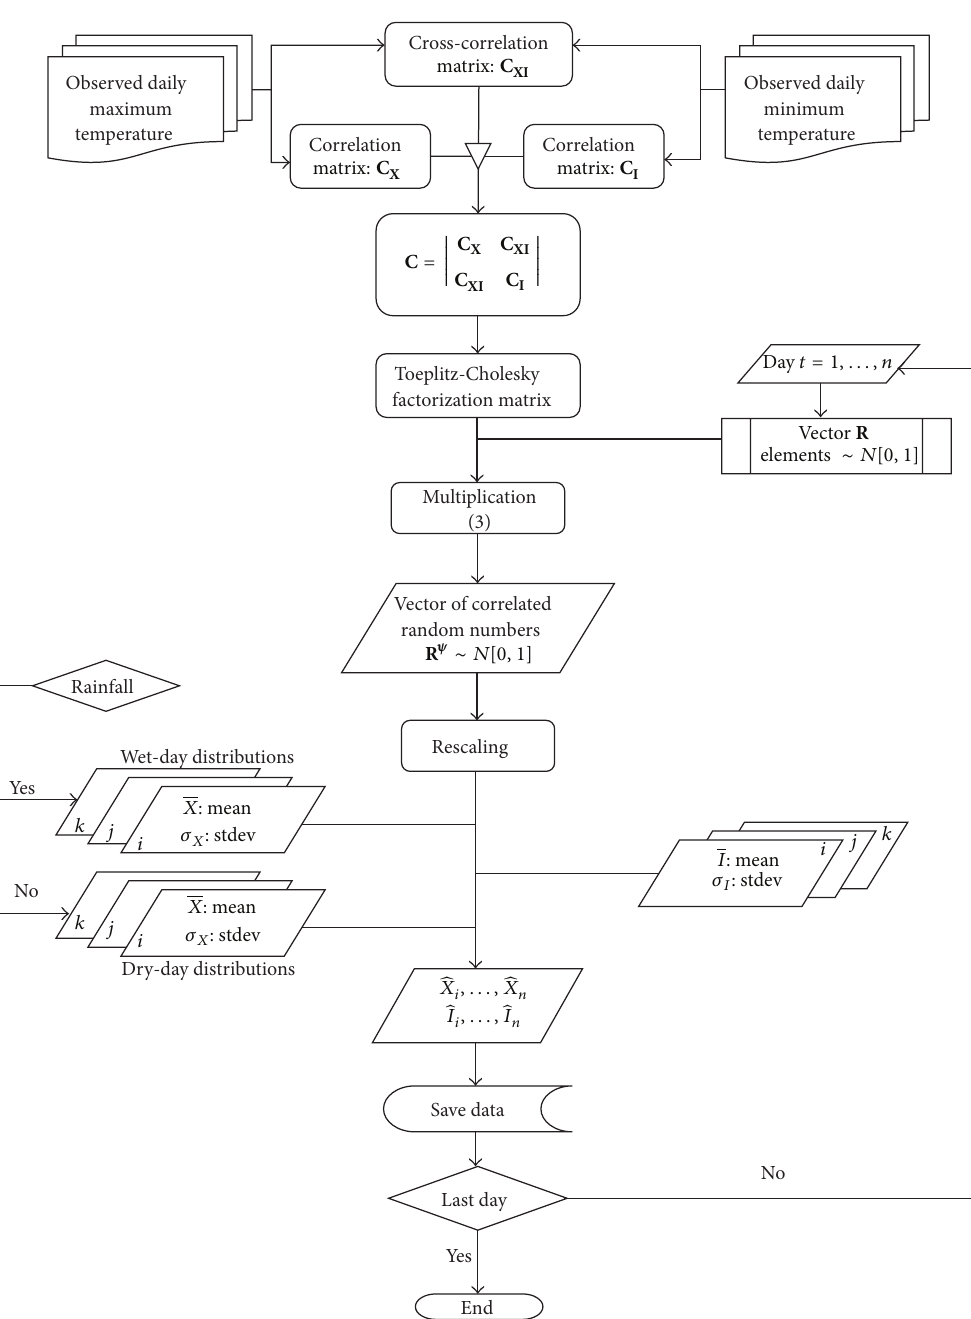
our experience, both methods perform equally well.) (see Section